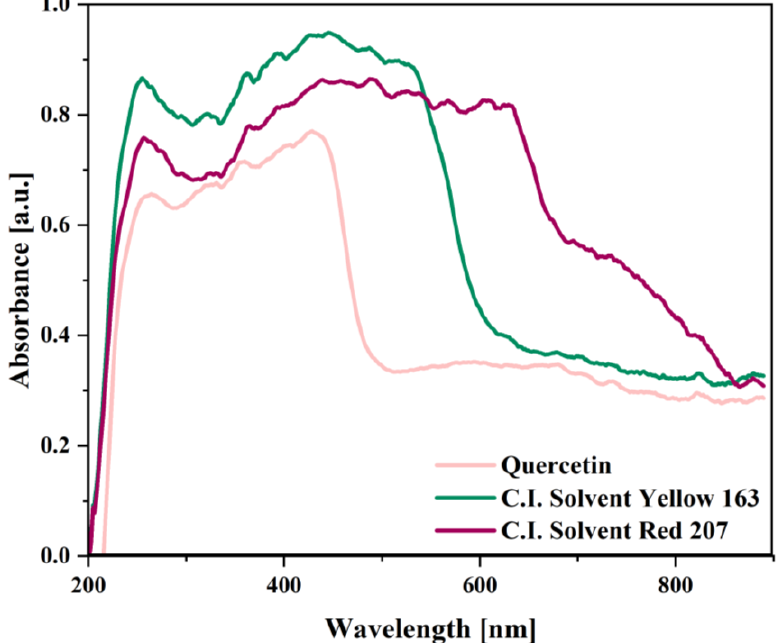
Figure 4. UV-Vis spectra recorded in the range of 190–1100 nm obtained for the tested natural and synthetic dyes: quercetin, C.I. Solvent Yellow 163, and C.I. Solvent Red 207. synthetic dyes: quercetin, C.I. Solvent Yellow 163, and C.I. Solvent Red